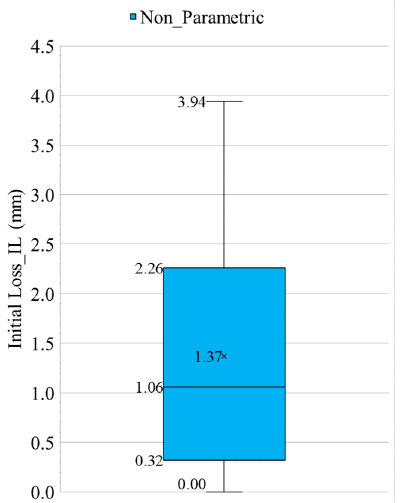
Figure 10. Box plot of IL based on non-parametric method for the urban portion .